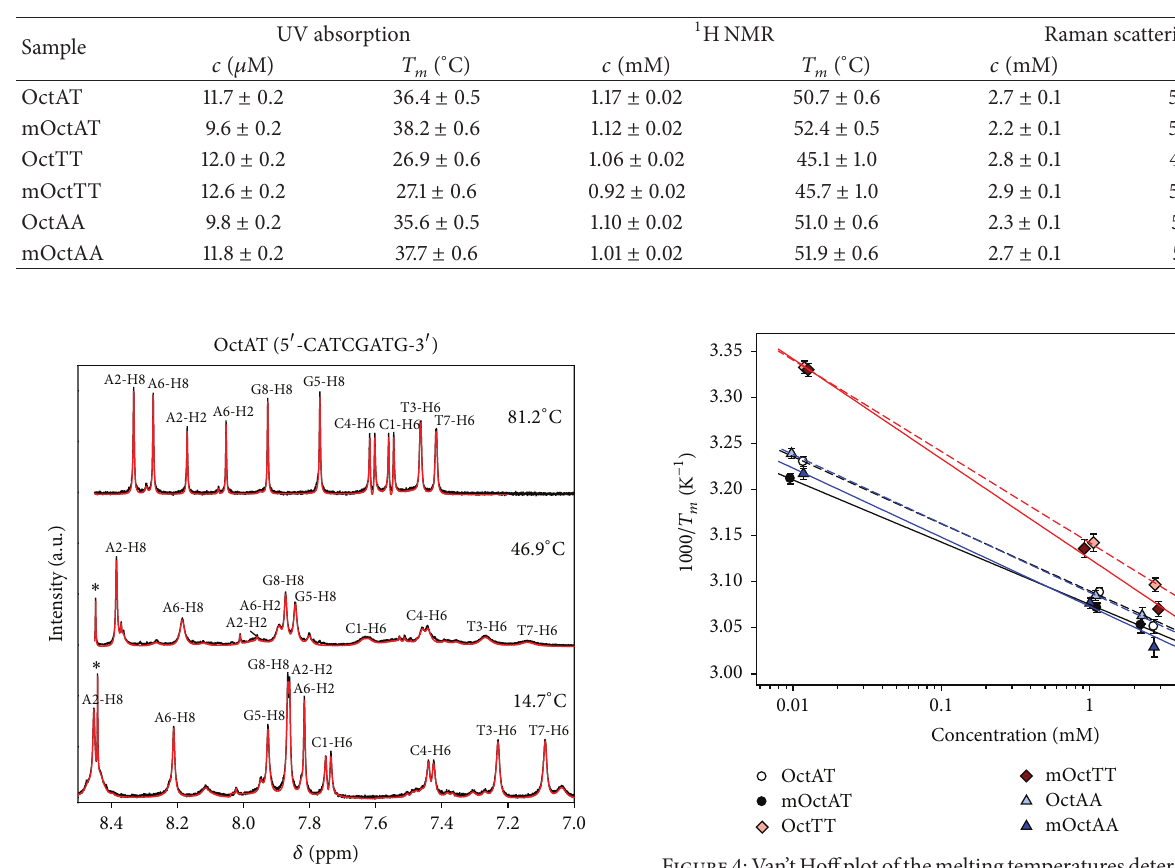
Table 1: The melting temperatures determined by particular spectroscopic techniques.